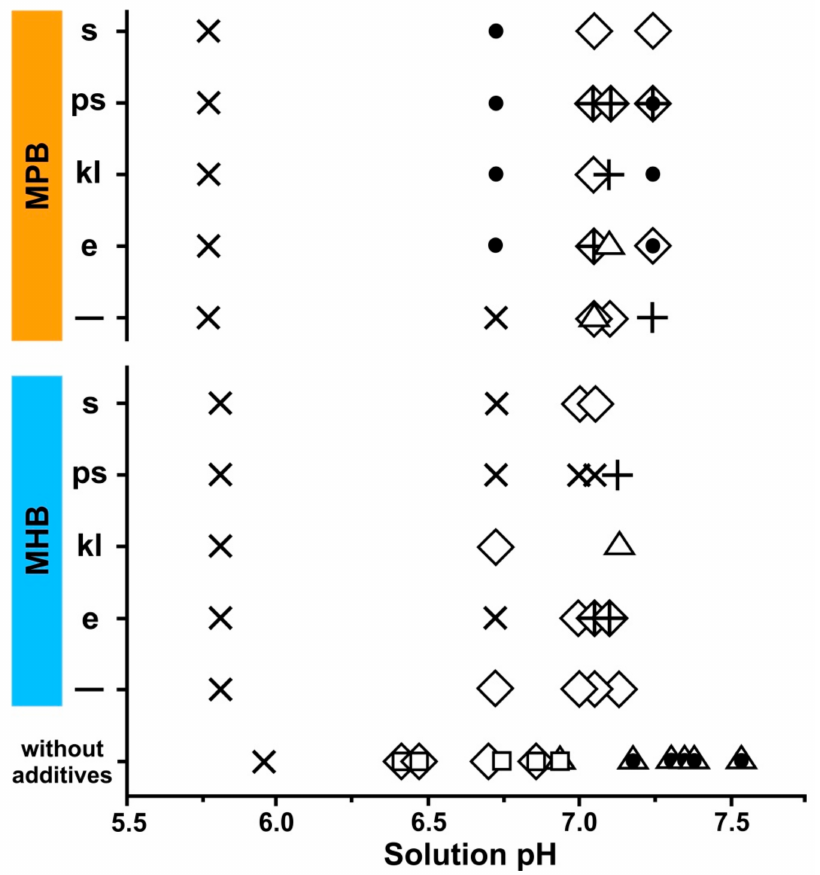
Figure 3. Phase composition of synthesized products from model solutions with minimum concentrations of additional ions characteristic of a healthy person’s urine composition.